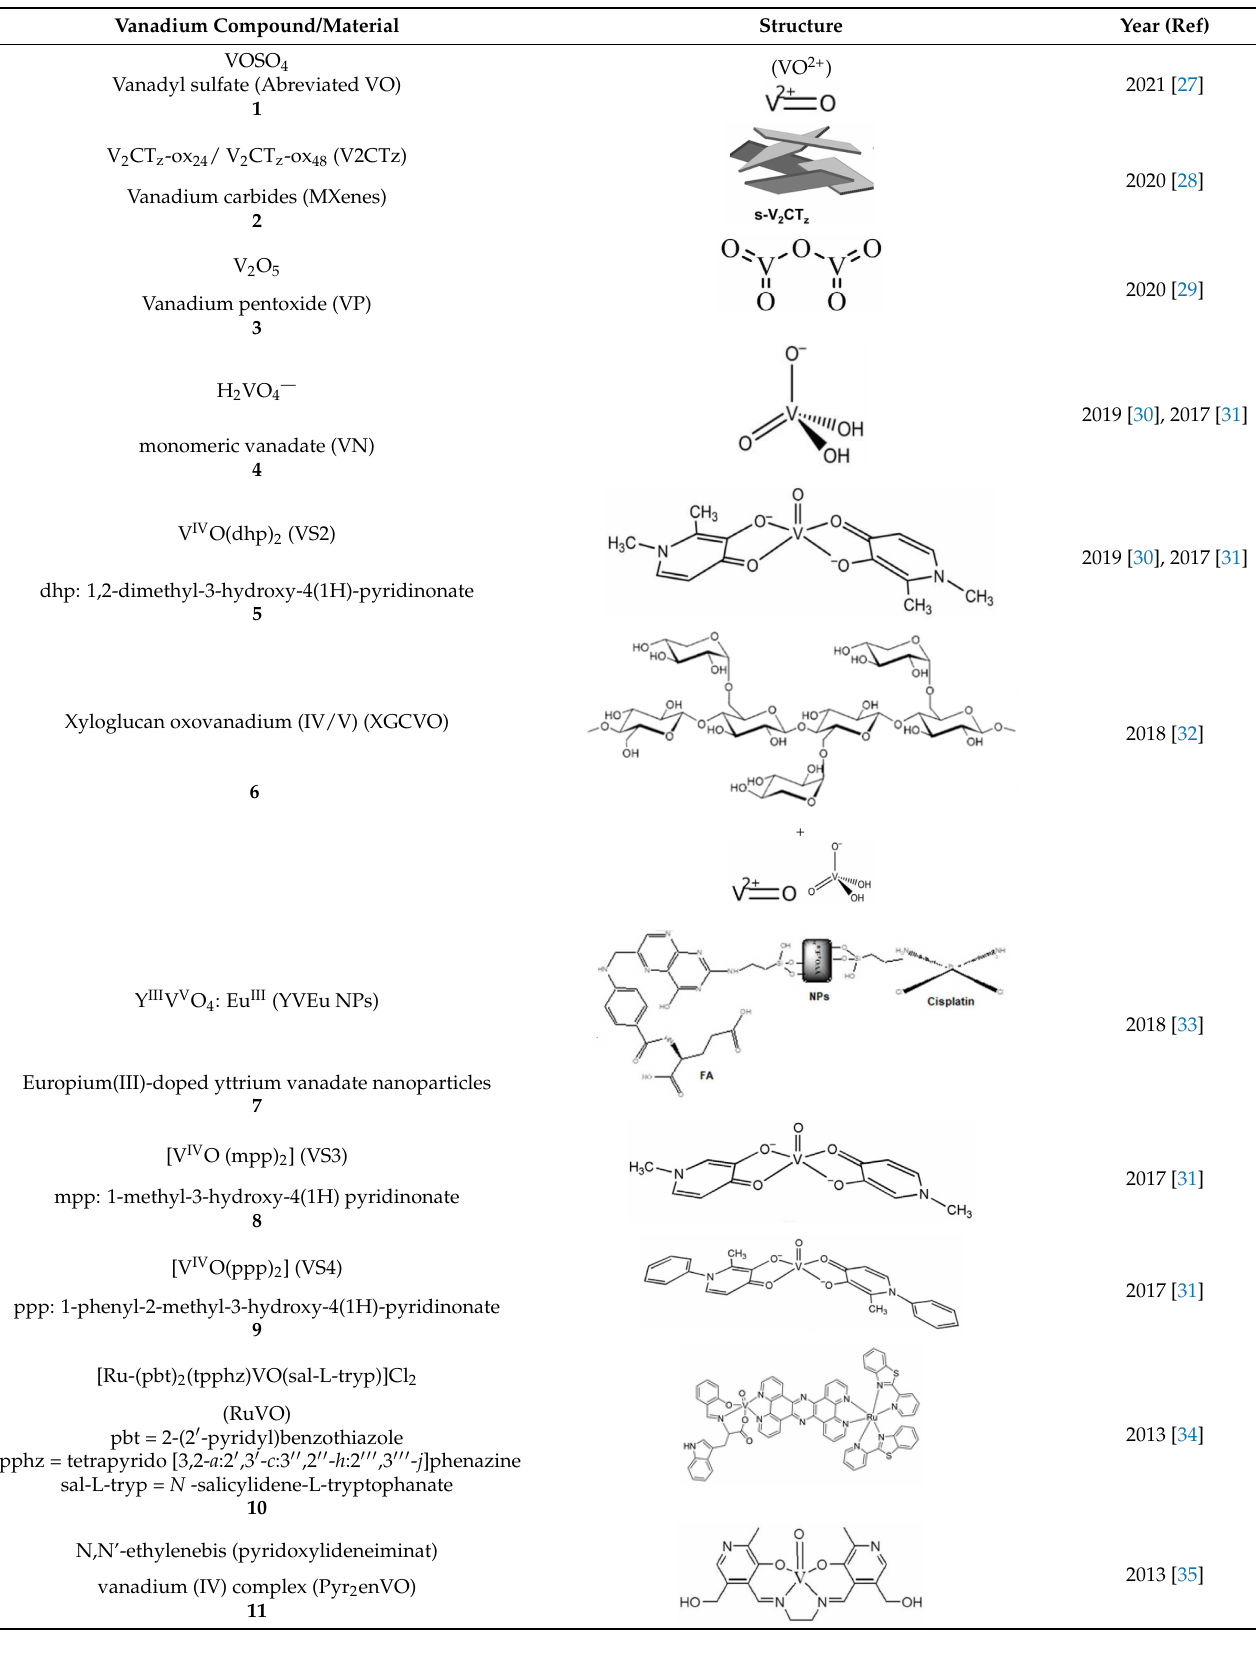
Table 1. Representation of the structures of vanadium compounds and/or vanadium materials included in the